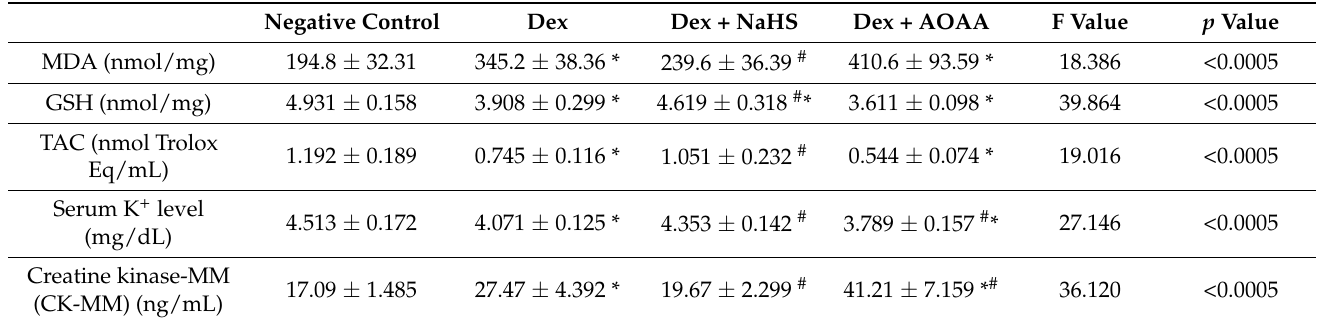
Table 6. Oxidative stress markers, serum K + level, and serum creatine kinase-MM (CK-MM) in different experimental